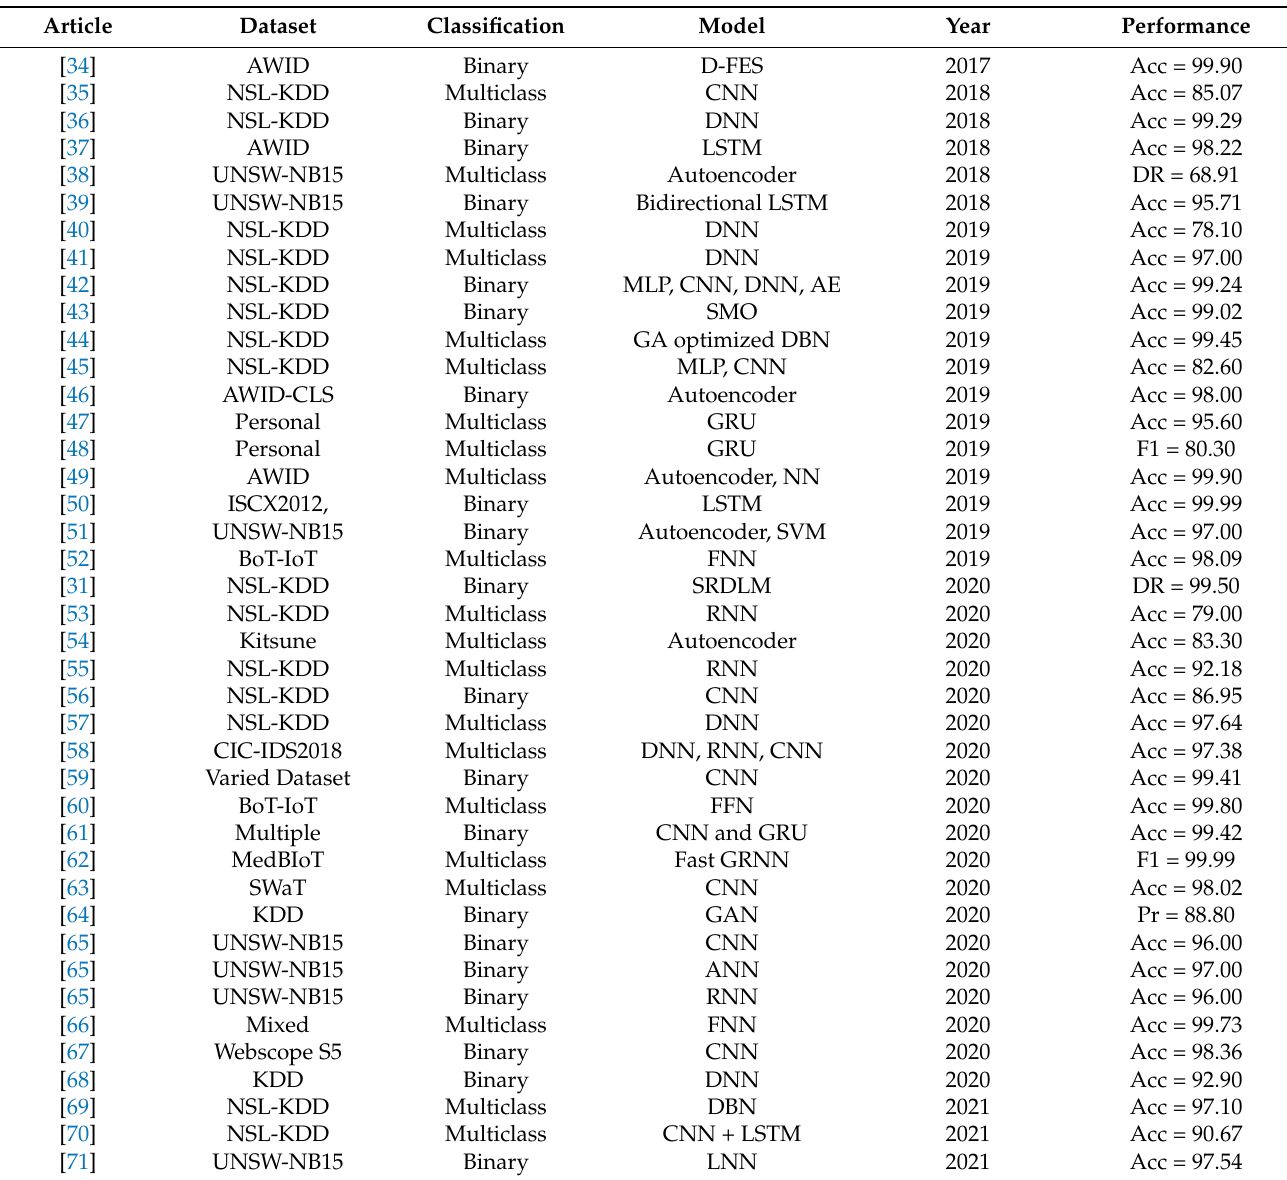
Table 1. Overview of related